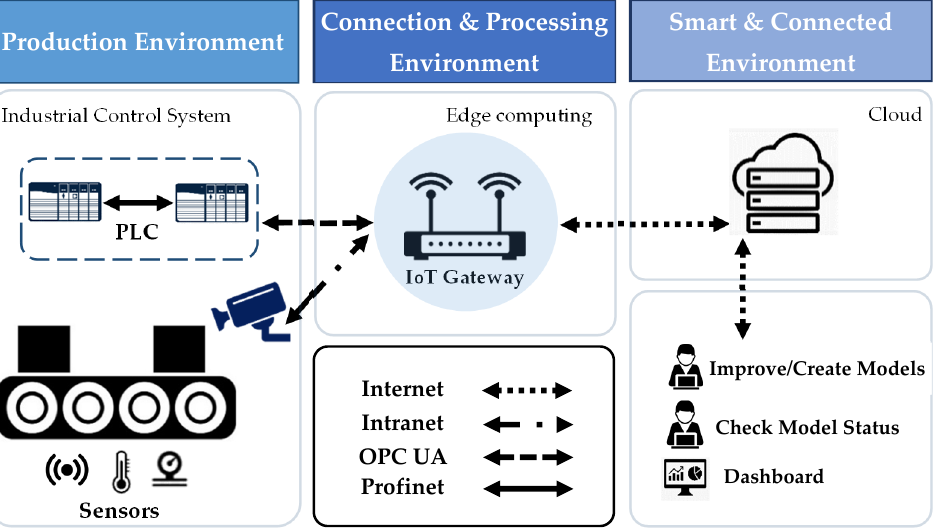
Figure 3. Internet of Things (IoT) architecture of the proposed model.